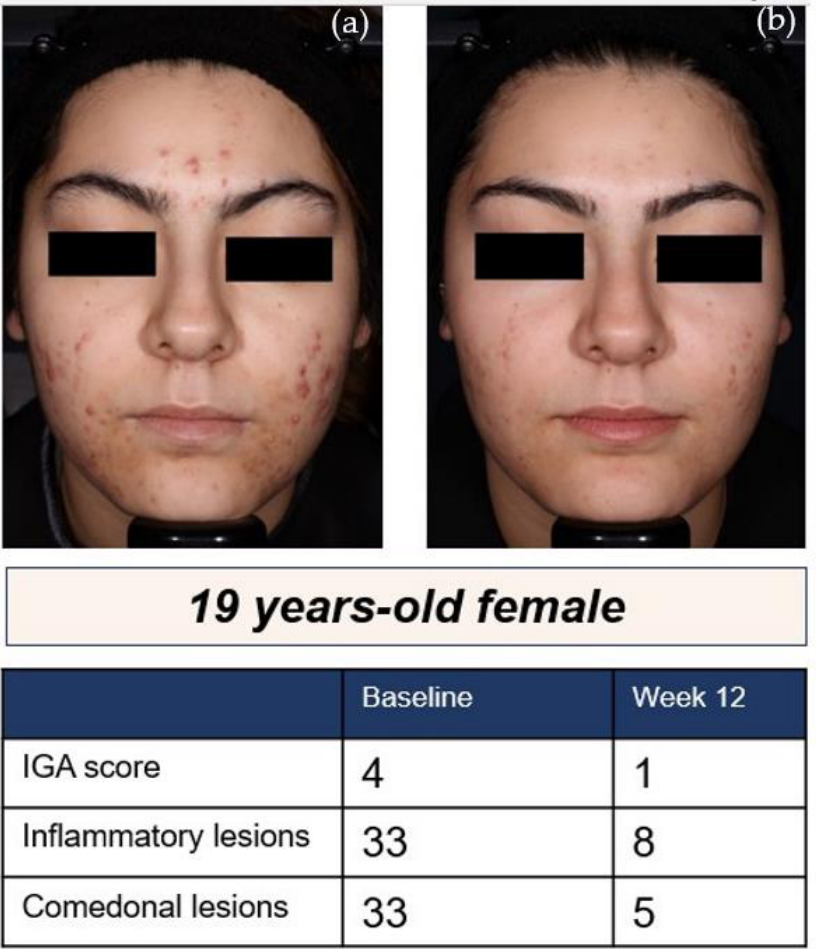
Figure 2. A 19-year-old Hispanic female [8]: ( a ) at baseline and; ( b ) after 12 weeks of treatment with sarecycline 1.5 mg/kg/day.